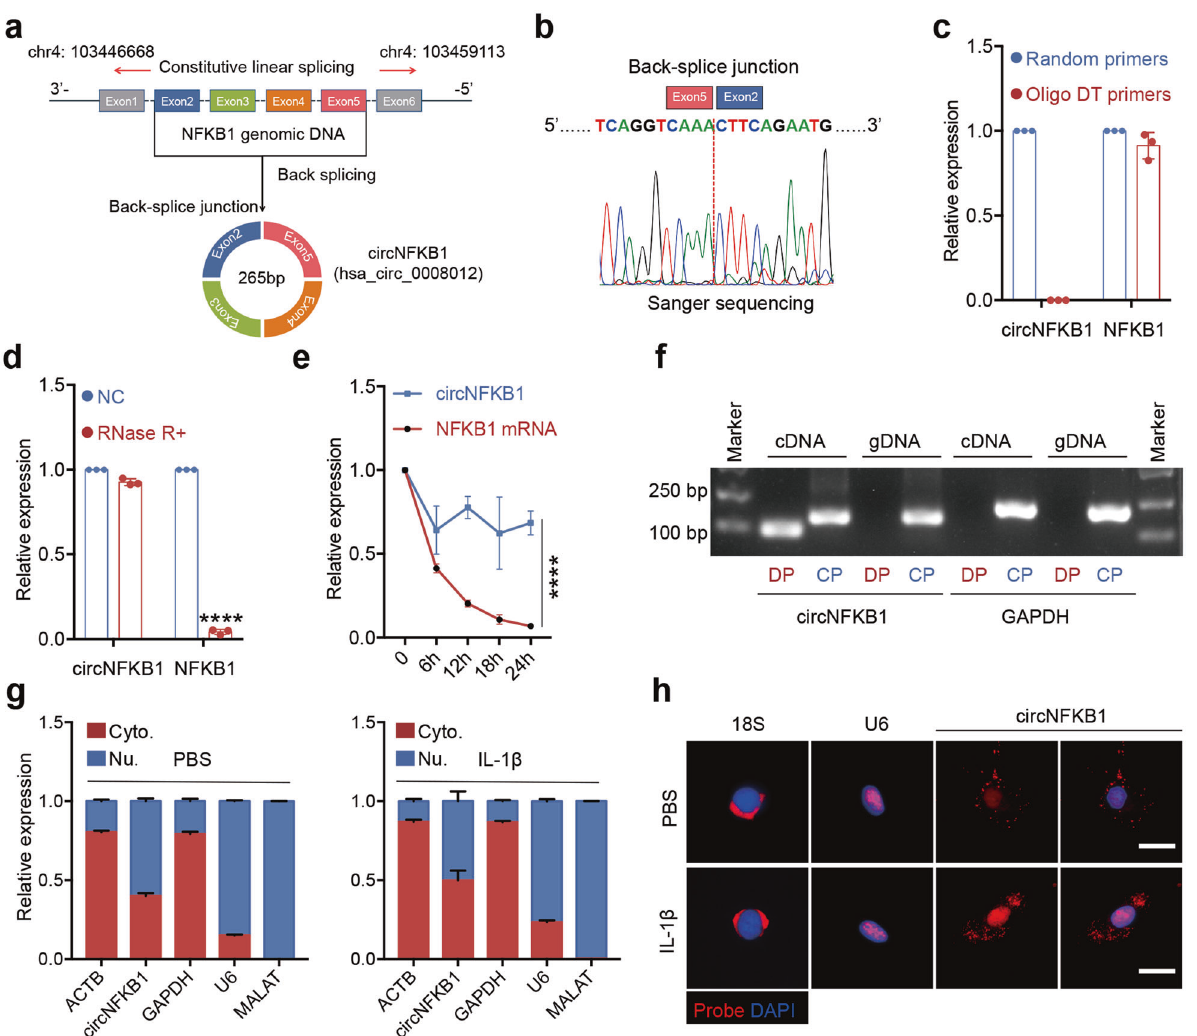
Fig. 2 Characterization of circNFKB1 in human chondrocytes. a Schematic illustration of circNFKB1 formation via the circularization of exons 2-3-4-5 in NFKB1 gene. b The back-splice junction sequence of circNFKB1 was validated by Sanger sequencing. c qRT-PCR results of circNFKB1 and linear NFKB1 mRNA using random primers or oligo DT primers. d qRT-PCR results of circNFKB1 and linear NFKB1 treated with or without RNase R. e Relative abundance of circNFKB1 and linear NFKB1 in HCs treated with actinomycin D. RNAs were measured via qRT-PCR at the indicated time. f PCR products of divergent or convergent primers and HCs cDNA or gDNA were validated by gel electrophoresis. g Subcellular distribution of circNFKB1 was detected by nuclear mass separation assay in HCs. MALAT1 and U6 acted as nuclear controls whereas GAPDH and ACTB acted as cytoplasm controls. h RNA-FISH images showing intracellular localization of circNFKB1 (red) in HCs. U6 and 18 S acted as nuclear and cytoplasm controls, respectively. Scale bar, 10 μ m. c – e , g n = 3 biologically independent experiments, mean values ± SD are shown, and p values were calculated by two-tailed Student ’ s t test ( d , e ). **** p < 0.0001. b , f , h , representative images are